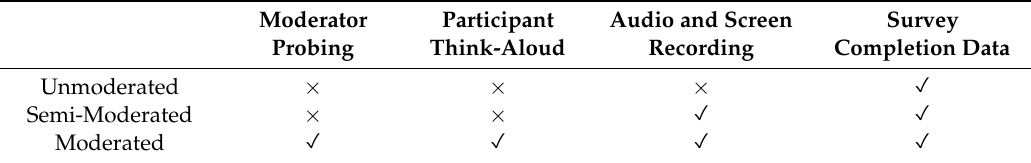
Table 1. Moderator-participant interactions and data sources in the three session types.